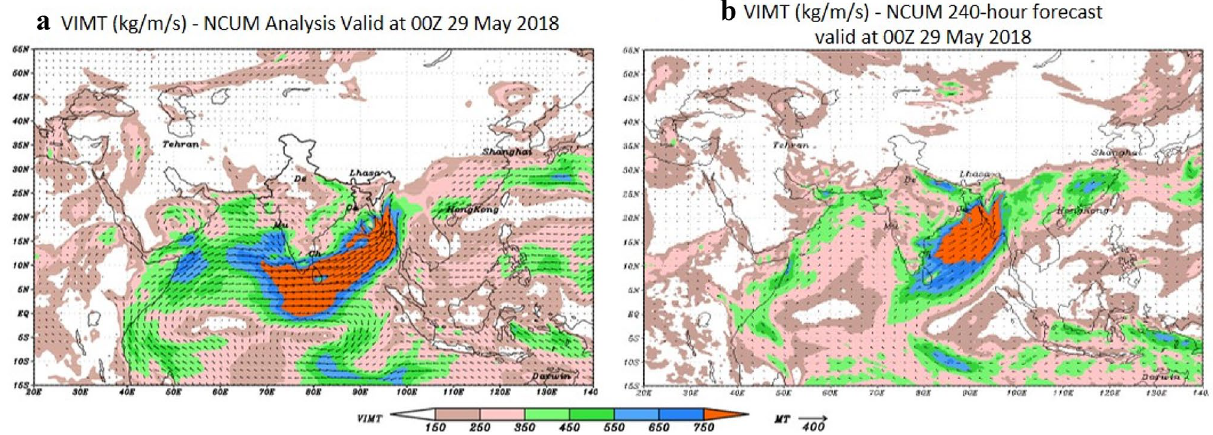
Fig. 3 The spatial distribution of NCUM Vertically Integrated Moisture Transport (VIMT, kg/m/s) for a analysis and b day 10 forecast valid at 00Z 29 May